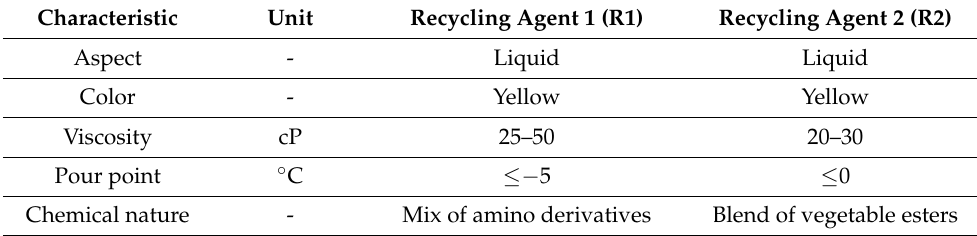
Table 2. Some of the given properties of the recycling agents.